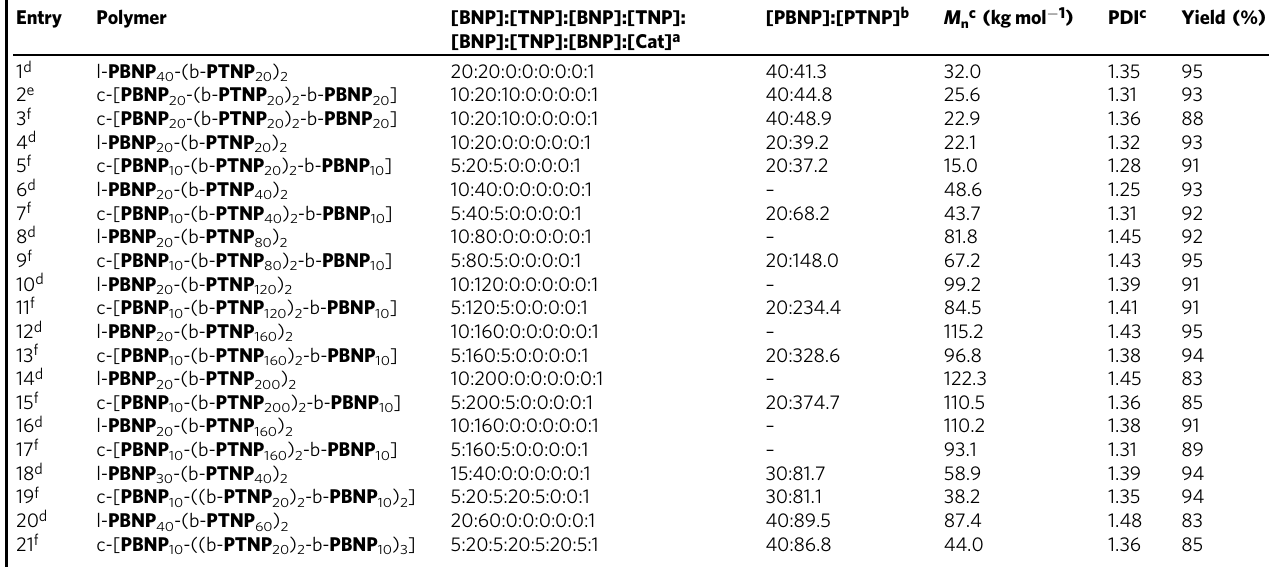
Table 1 Characteristics for linear and cyclic polymers Entry